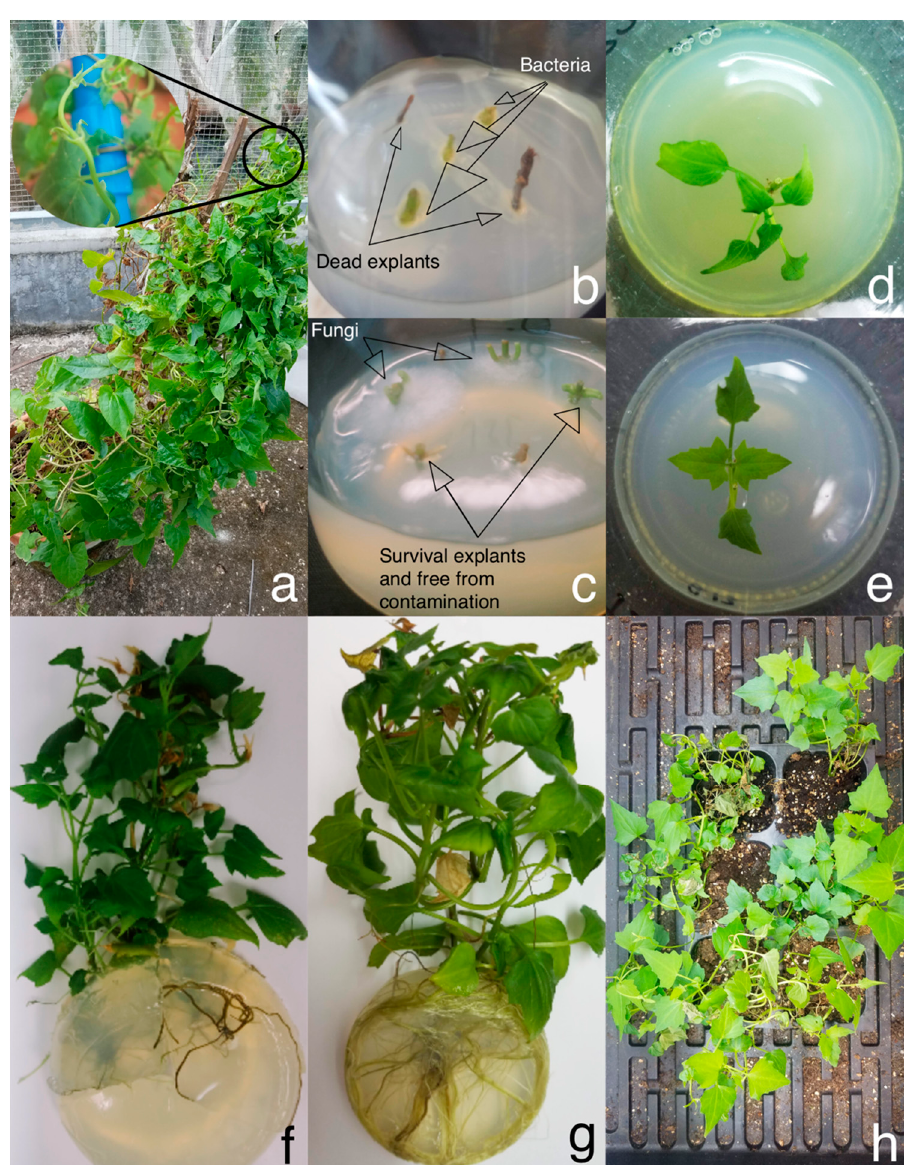
Figure 1. Micropropagation of M. cordata . ( a ) A greenhouse-grown M. cordata and the juvenile shoots (in the circle) were collected as explant donors. ( b ) On the 6th day, three explants were colonized by bacteria and two explants died in one antibiotic-free medium. ( c ) On the 6th day, two explants were colonized by fungi and two explants were potentially aseptic in one TIM-treated medium. ( d ) The plantlet had sprouted after 6 weeks of cultivation with CTX. ( e ) The plantlet had sprouted after 6 weeks of cultivation with TIM. ( f ) After 8 weeks of cultivation on 1 / 2 MS media with CTX, the plantlet grew sparse roots with relatively small leaves. ( g ) After 8 weeks of cultivation on 1 / 2 MS media with TIM, the plantlet grew lush roots with relatively large leaves. ( h ) The robust plantlets were transferred to plastic pots containing soil and sand (1:1) mixture and were able to establish ex vitro after 4 weeks of cultivation. Abbreviation: CTX, cefotaxime; TIM, timentin; MS, Murashige and